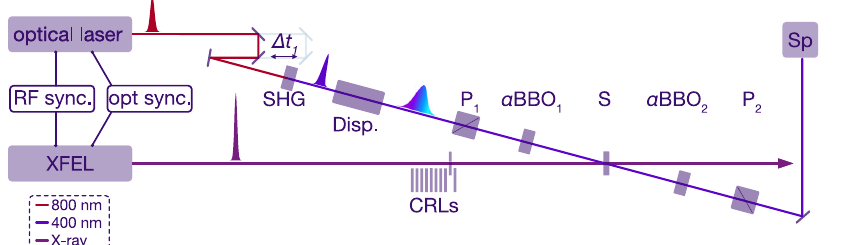
Fig. 1 | Self-referenced timing tool setup. An ultrashort 800 nm optical pulse is guided throughamotoriseddelaystage Δ t 1 and frequency doubled to 400nmina second harmonic generation (SHG) crystal. A dispersive fl int glass block (Disp.) is used to further chirp the optical pulse duration. The chirped pulse is guided through the Common-Path-Interferometer (CPI) consisting of two polarisers P 1,2 and two a-cut α BBO 1,2 crystals. The optical pulse and the X-ray pulse (XFEL) are